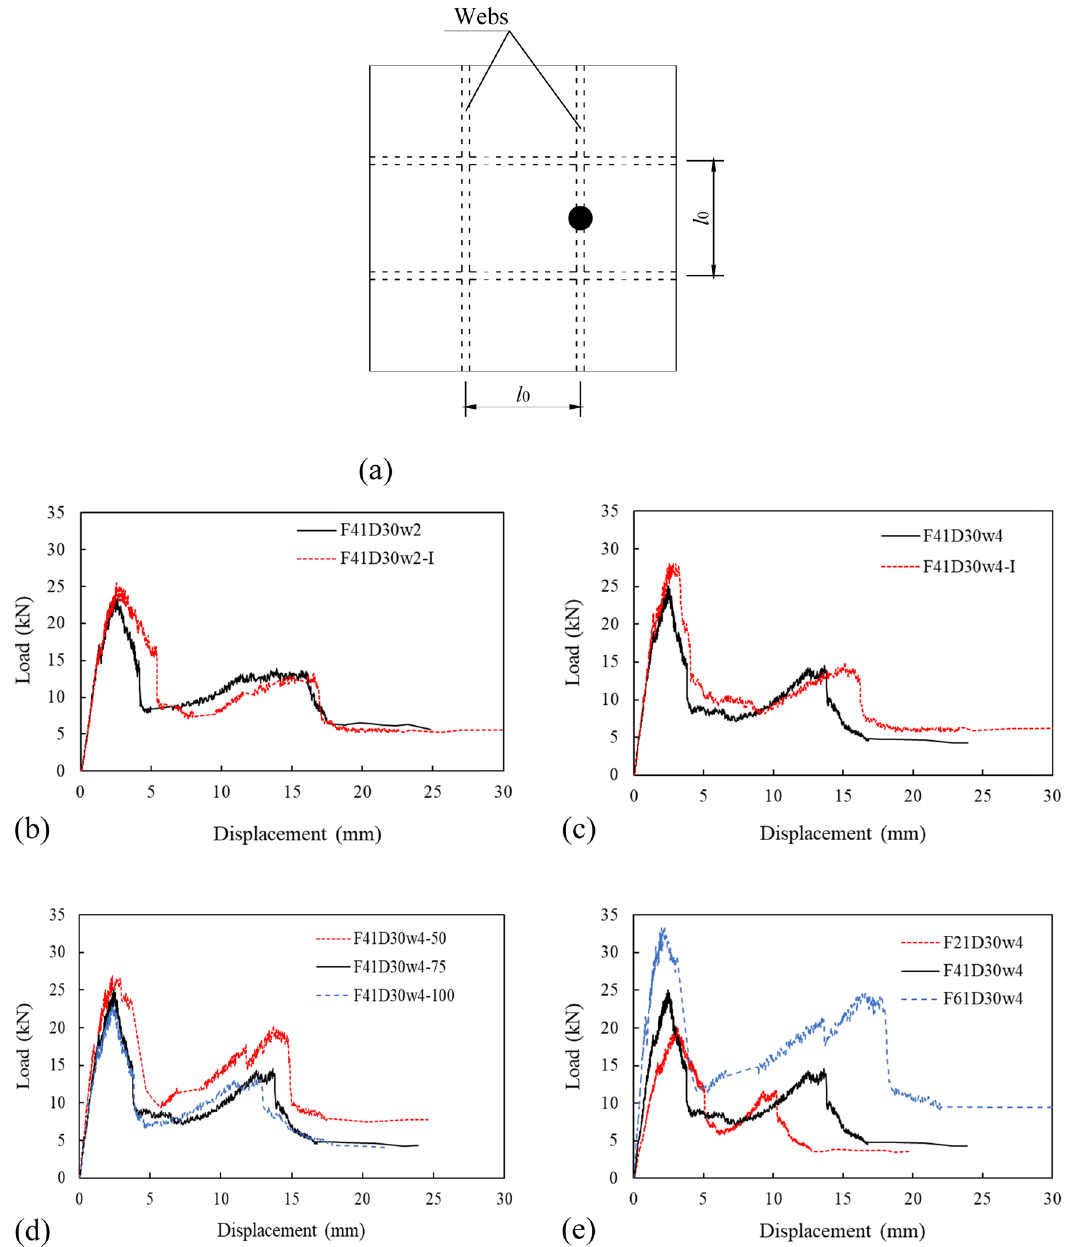
Figure 12: Influenceofvariedparametersontheload – displacementcurves.Note:Inthespecimenname,Imeanstheloadisappliedontheweb;and50, 75, and 100 mean the distance of webs are 50, 75, and 100mm, respectively. ( a ) Simulated loading position. ( b ) Influence of loading position of F41D30w2. ( c ) InfluenceofloadingpositionofF41D30w4. ( d ) Influenceofdistanceofwebs. ( e )